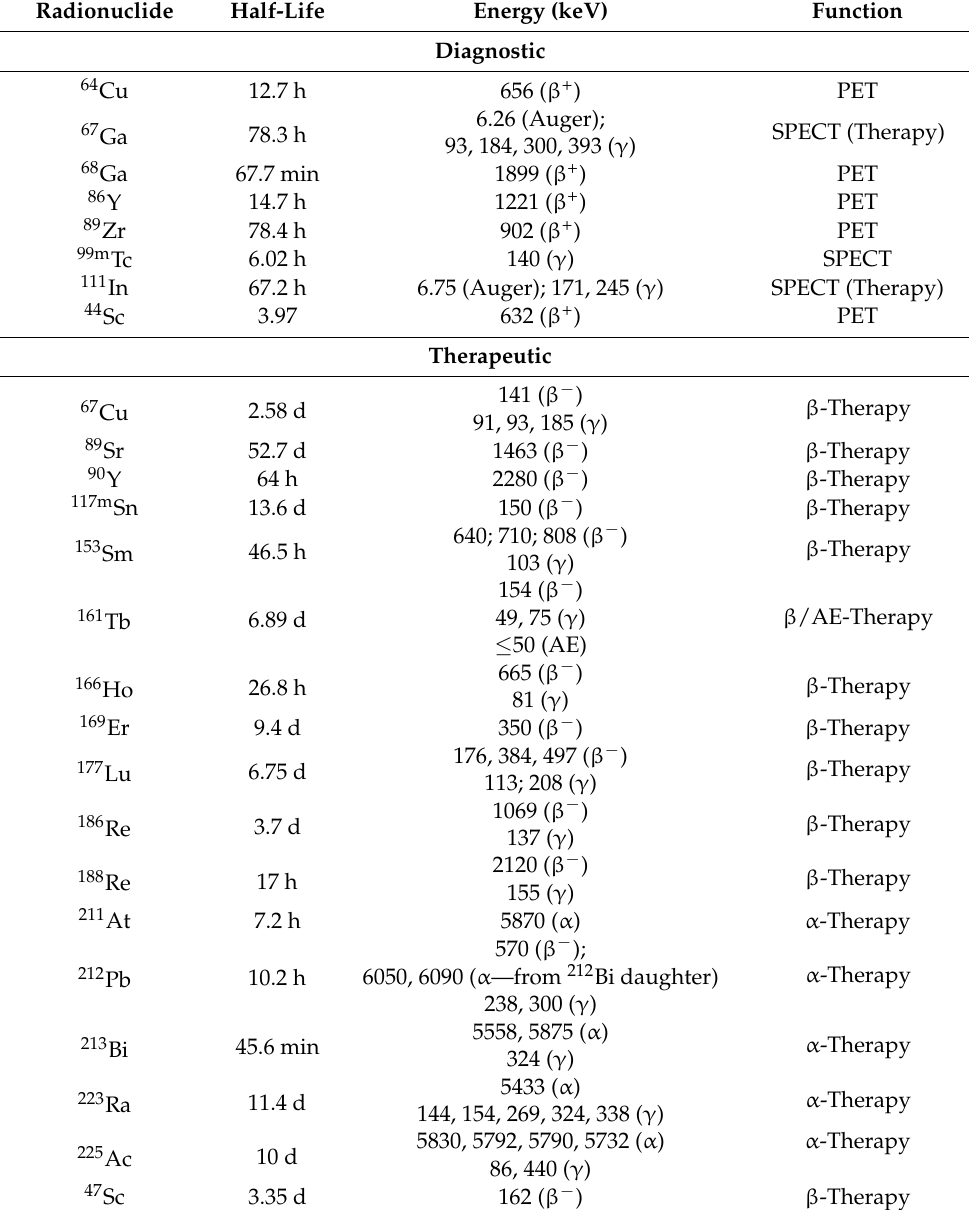
Table 2. Radiometals commonly used for nuclear imaging and therapy purposes. Adapted from ref.